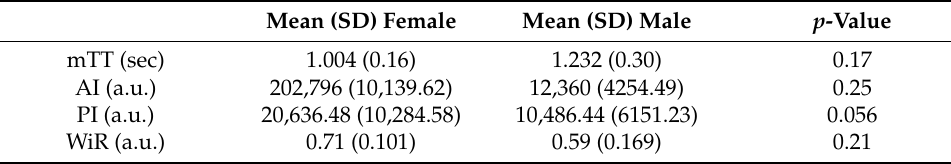
Table 4. Association of gender with perfusion variables.